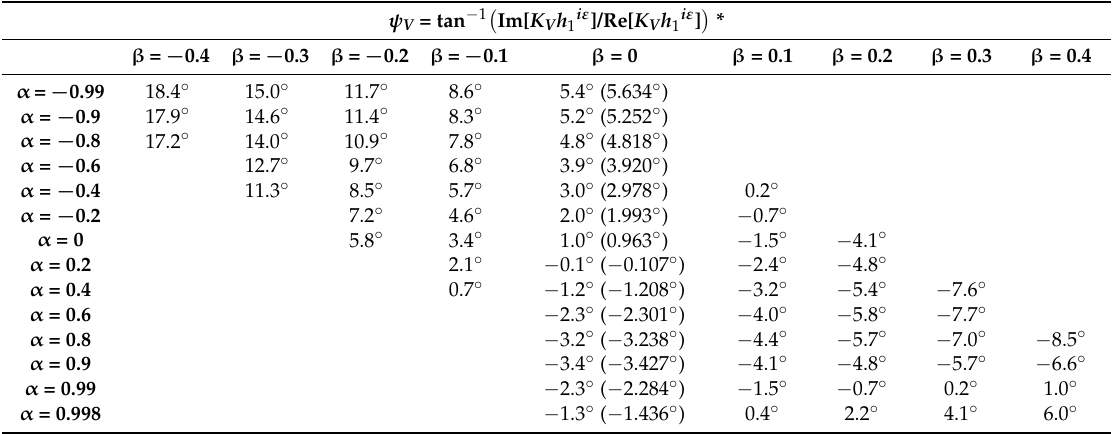
Table 4. The mode-mixity phase angle associated with the elementary shear load, Figure 1a, with V (cid:54) = 0, P = M = 0.